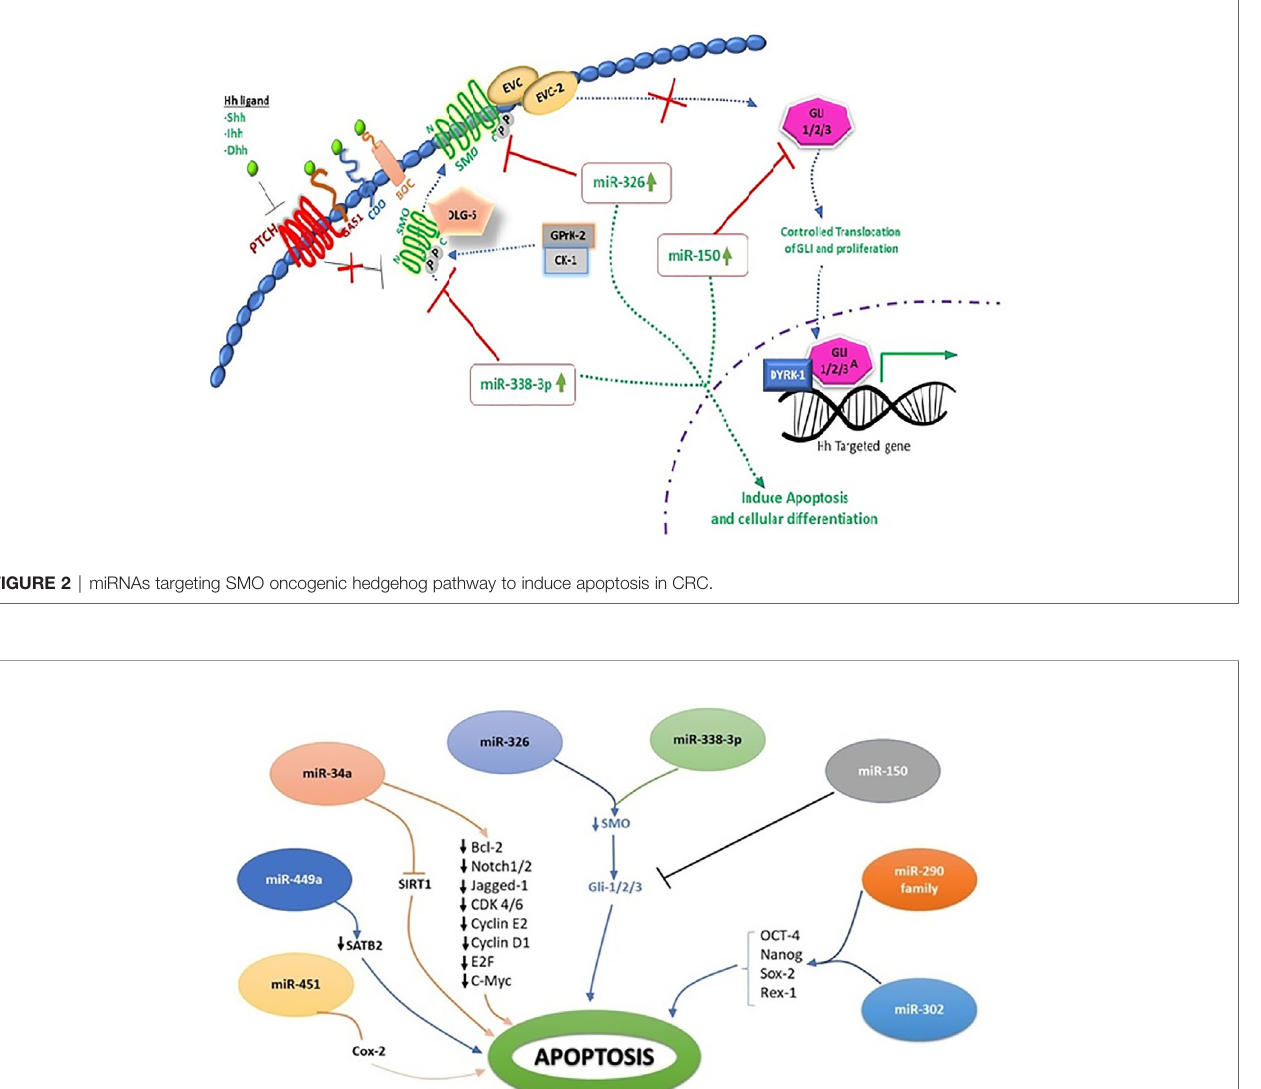
FIGURE 3 | Molecular interplay between several miRNAs and their downstream target genes to induce